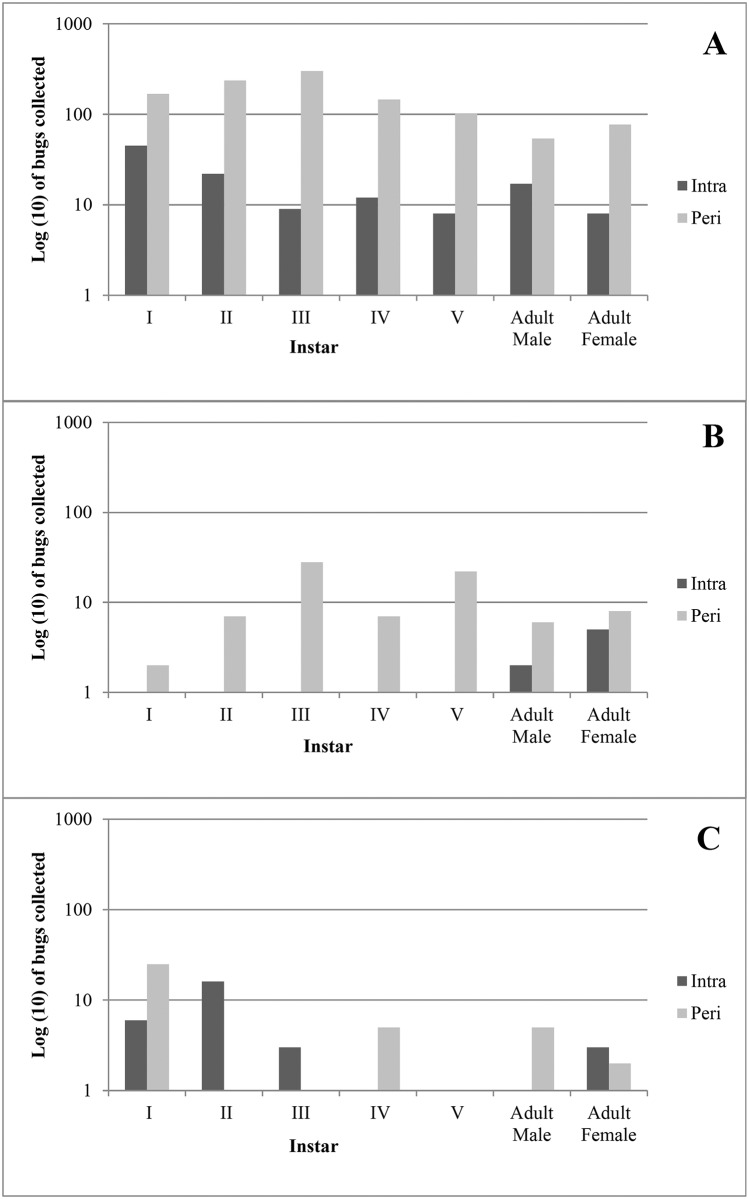
Population structure of triatomines collected in rural communities of Manabí province, Ecuador.Number of live Nymphal I-V and adult female and male bugs collected in domestic (Intra) and peridomestic (Peri) habitats. A) R. ecuadoriensis, B) P. howardi and C) P. rufotuberculatus.